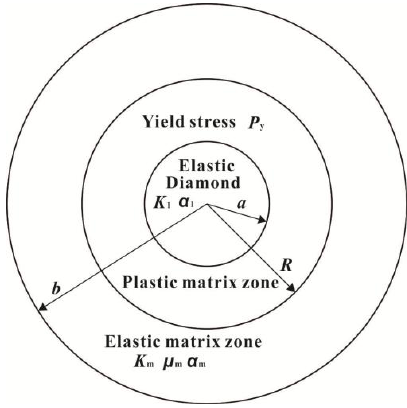
Figure 16. Scheme of simplified model of diamond-matrix.